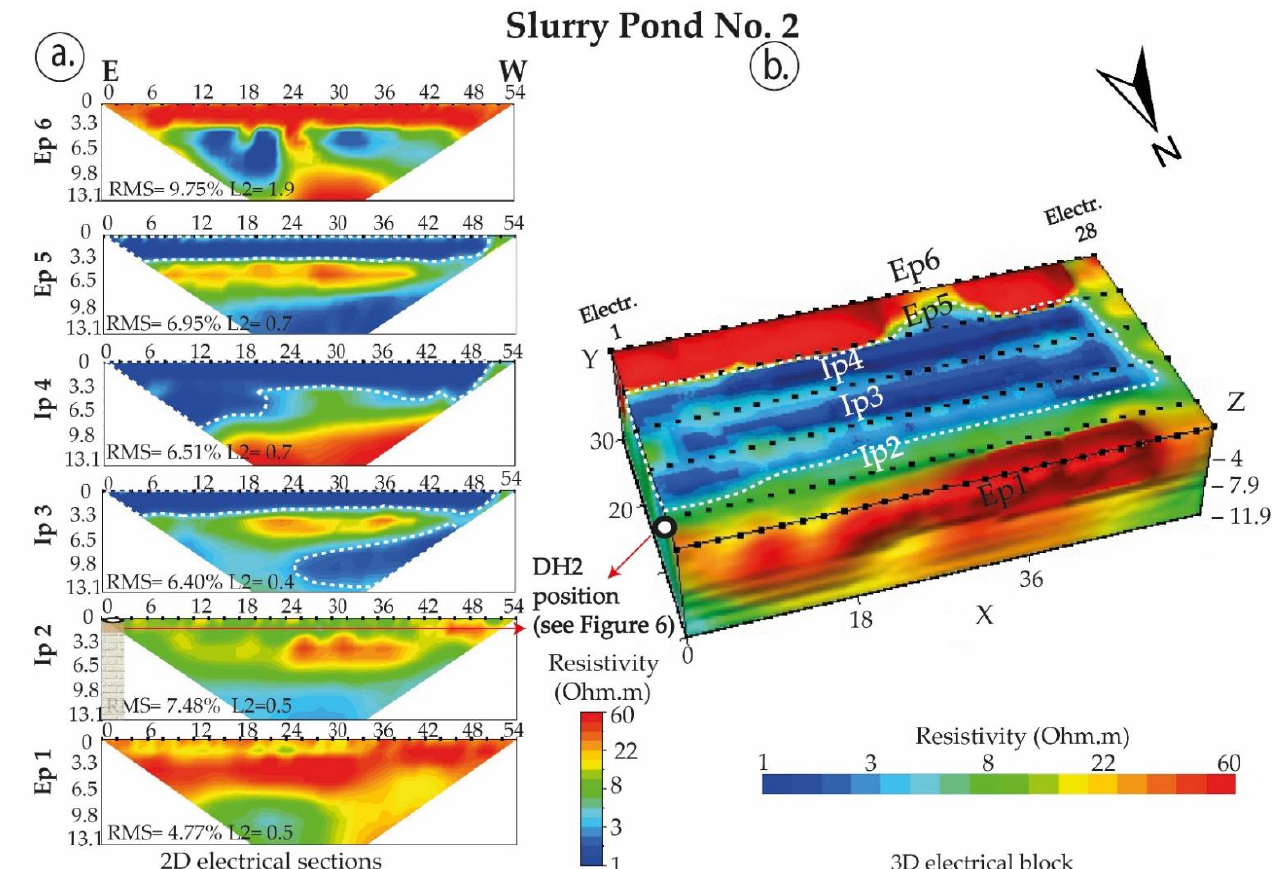
Figure 8. Slurry pond No. 2. ( a ) ERT 2D electrical sections and ( b ) ERT 3D electrical block. RMS and L2 stand for root-mean squared error and L2 norm, respectively. Electrode spacing is 2 m.